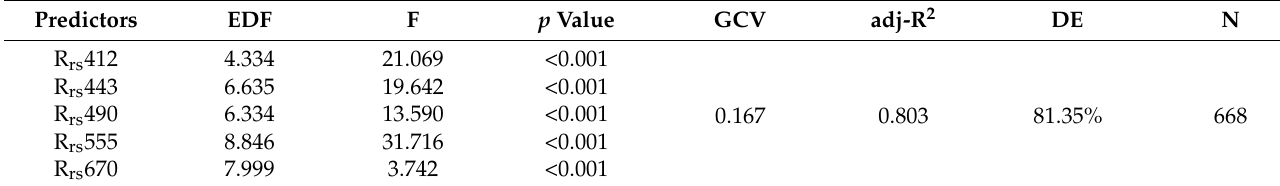
Table 6. Statistical summary of the fitted diatoms GAM.